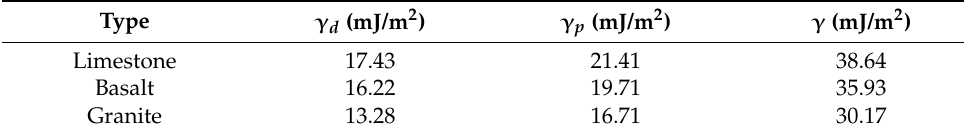
Table 4. Surface free energy parameters of the three